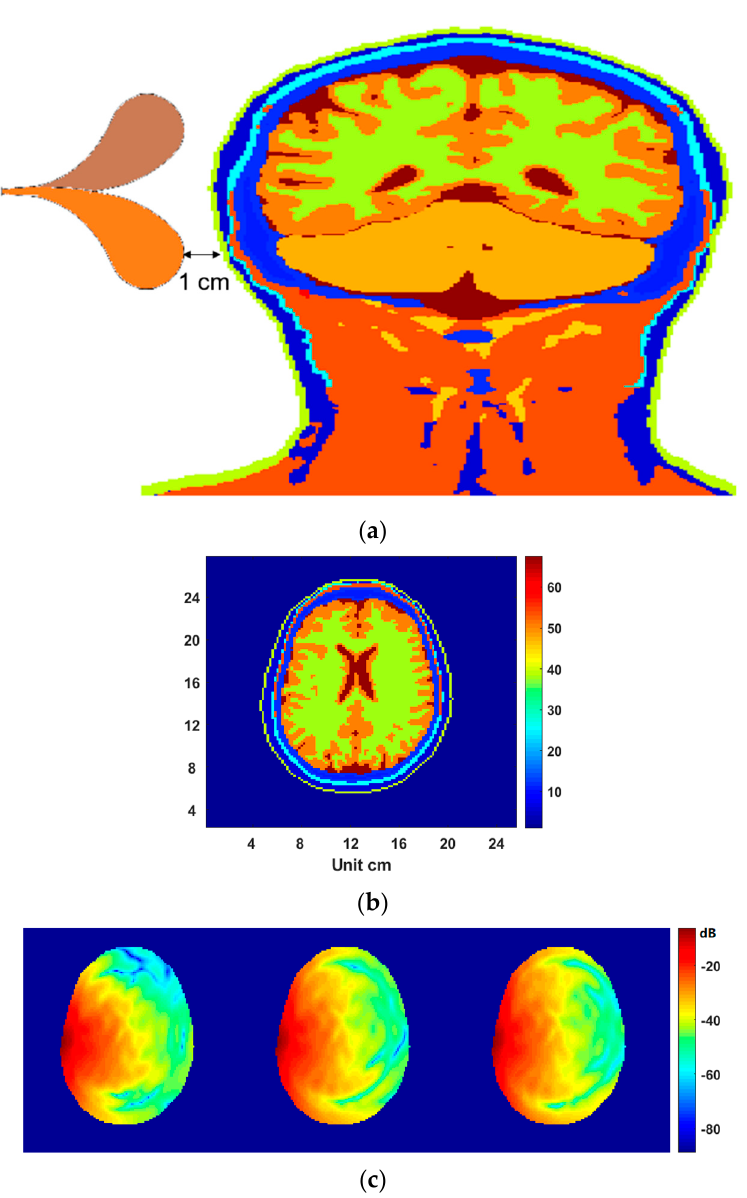
Figure 7. Electromagnetic field in a head. ( a ) measurement setup; ( b ) a slice extracted from the 3D dielectric head model in the trans − axial plane; ( c ) From left to right: field in the slice plane shown in ( b ) when the head is exposed in air, in 70% isopropyl, and in glycerin,